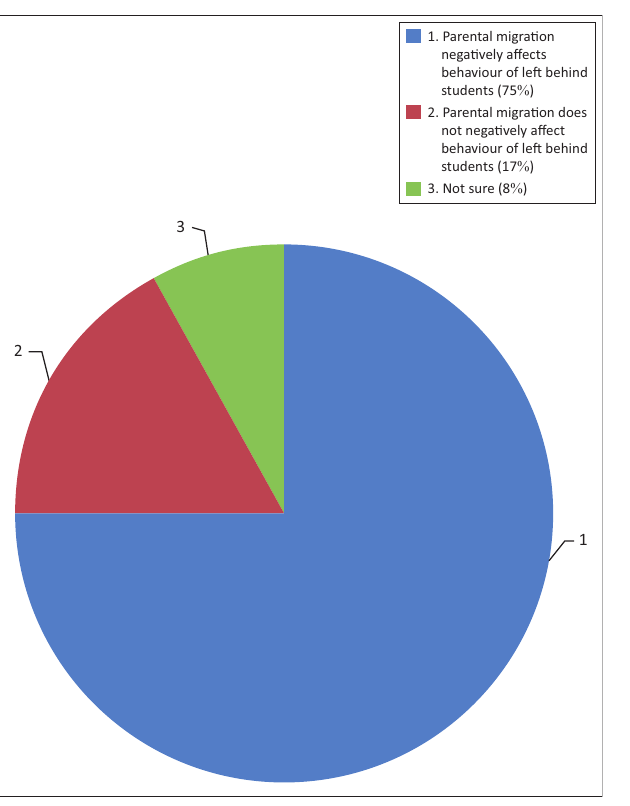
FIGURE 2: Perceived behaviour of left-behind students. FIGURE 3: Left-behind students and discipline issues at